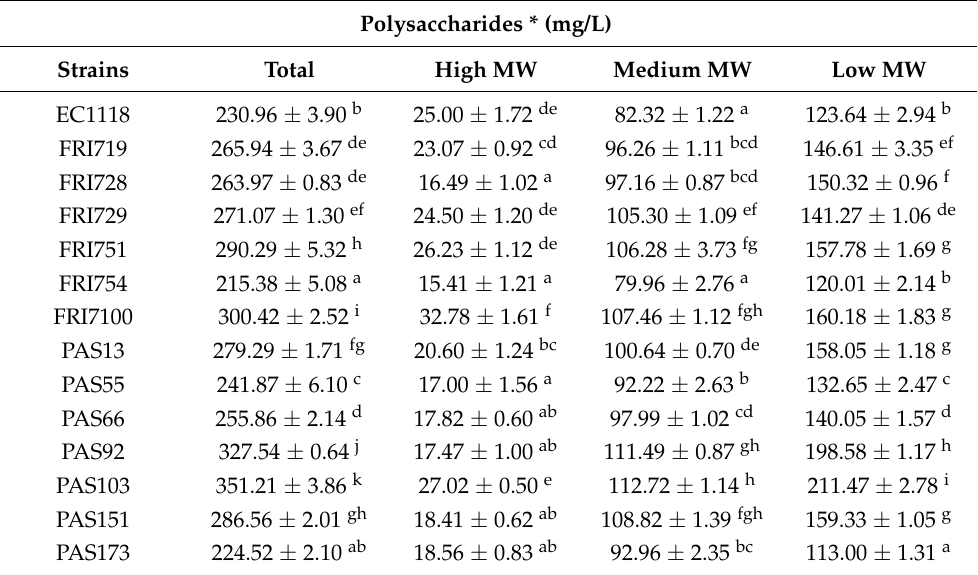
Table 5. Total polysaccharides and their fractions by SEC-HPLC in Pinot grigio